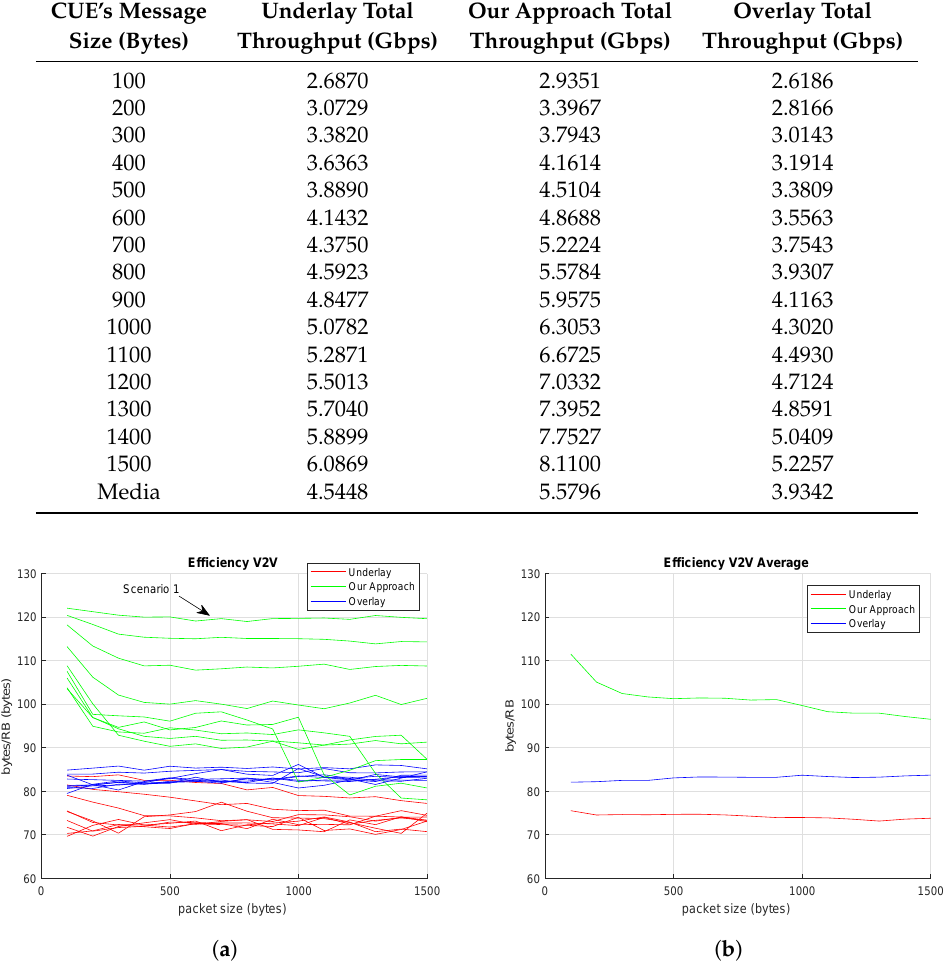
Figure 6. Spectral Efficiency offered to V-UEs based on C-UEs’ traffic pattern. ( a ) Total Average Spectral Efficiency for V-UEs in different scenarios; ( b ) Total Average Spectral Efficiency for